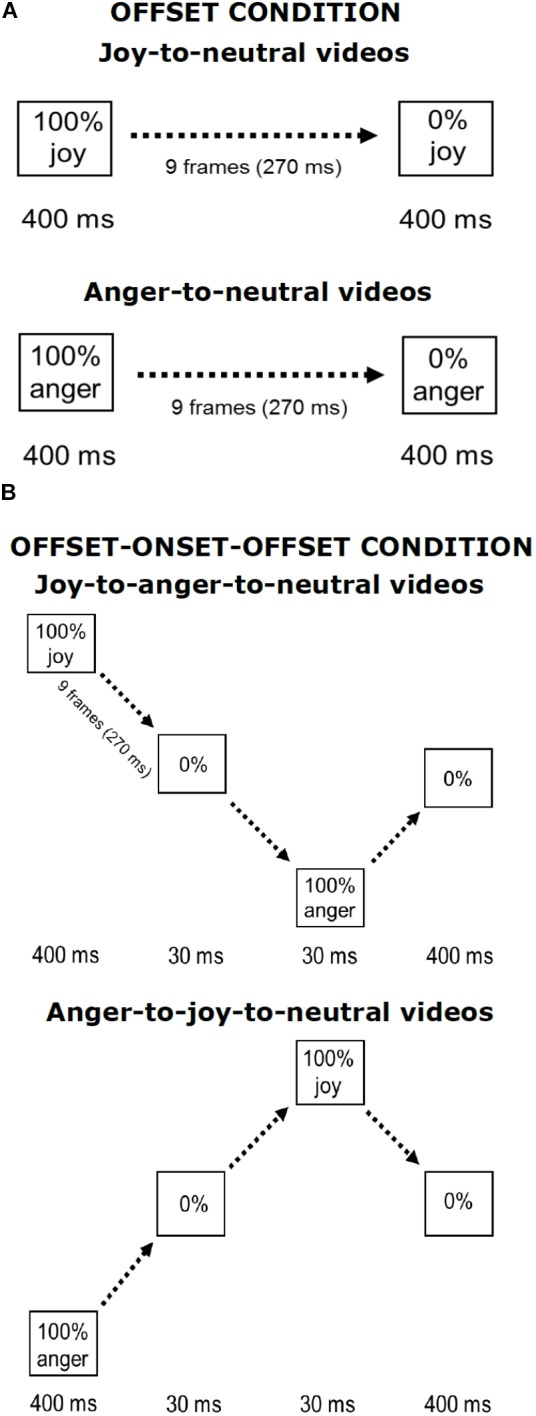
Mean ratings on the 5-point scale (y-axis) for the neutral expressions at the end of the video sequences for each of the eight actors (x-axis) in the Offset condition (left panels) and in the Offset-onset-offset condition (right panels) for the HFA (top row) and TD (bottom row) groups.